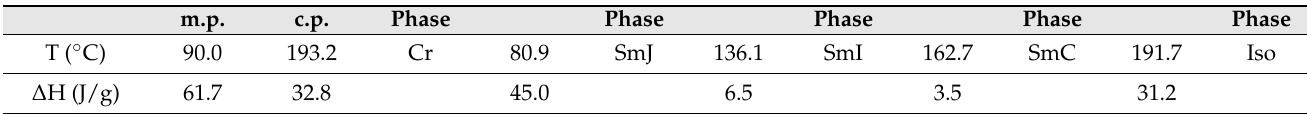
Table 1. Mesophase transitions determined by DSC (cooling rate of 5 K/min) of the sample labelled ‘C’. Phase transition temperatures (T, °C) and phase transition enthalpy ( Δ H, J/g) measured at the second DSC cycle are shown. The values of melting point (m.p.) and clearing point (c.p.) (measured on heating) are reported.